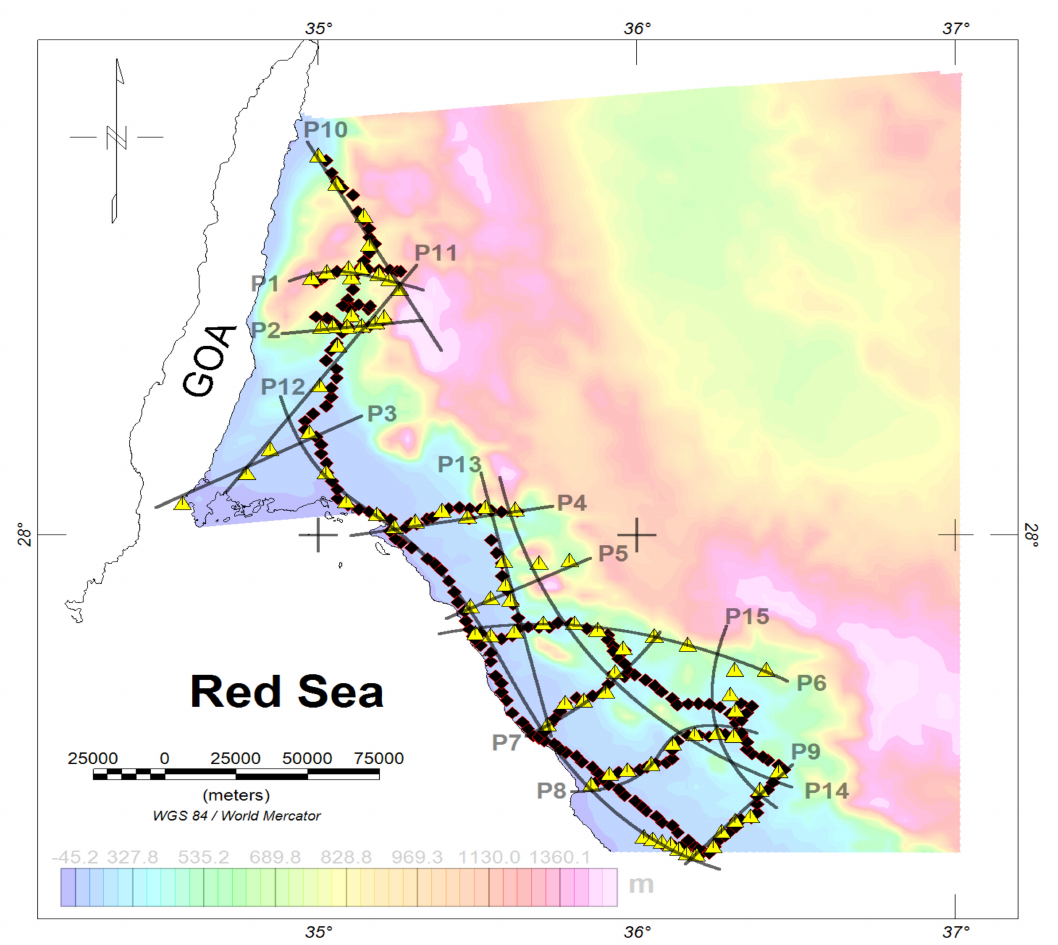
Figure 2. Yellow-filled triangles show the location of the AMT stations; black-filled red squares are the gravity stations. P1–P15 are the selected profiles for modelling; DEM is the